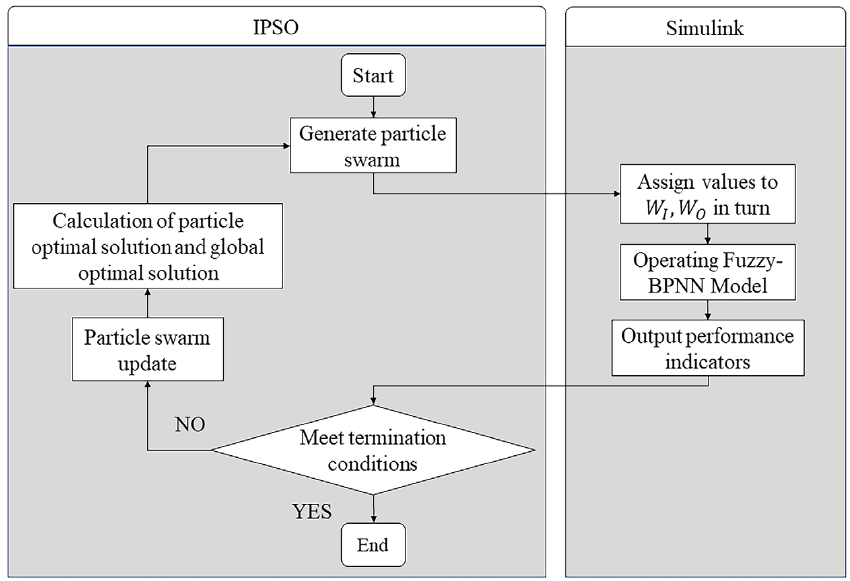
Figure 12. The flowchart of proposed controller.